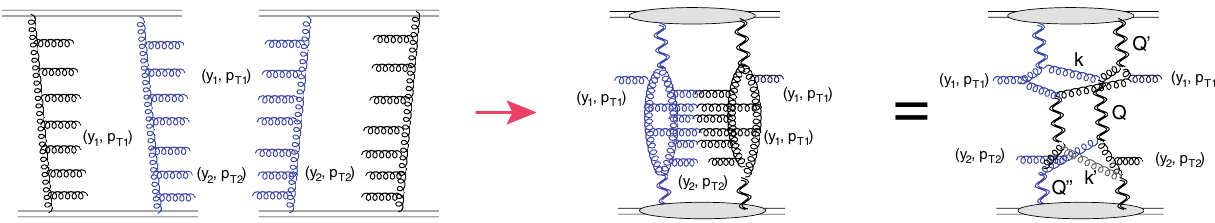
Fig. 2 The generalization of Fig. 1b for ¯ α S y 12 (cid:2) 1. The wavy lines show the BFKL Pomeron[40–43], while the helical lines denote gluons. The color (blue and black) of the lines indicates the parton